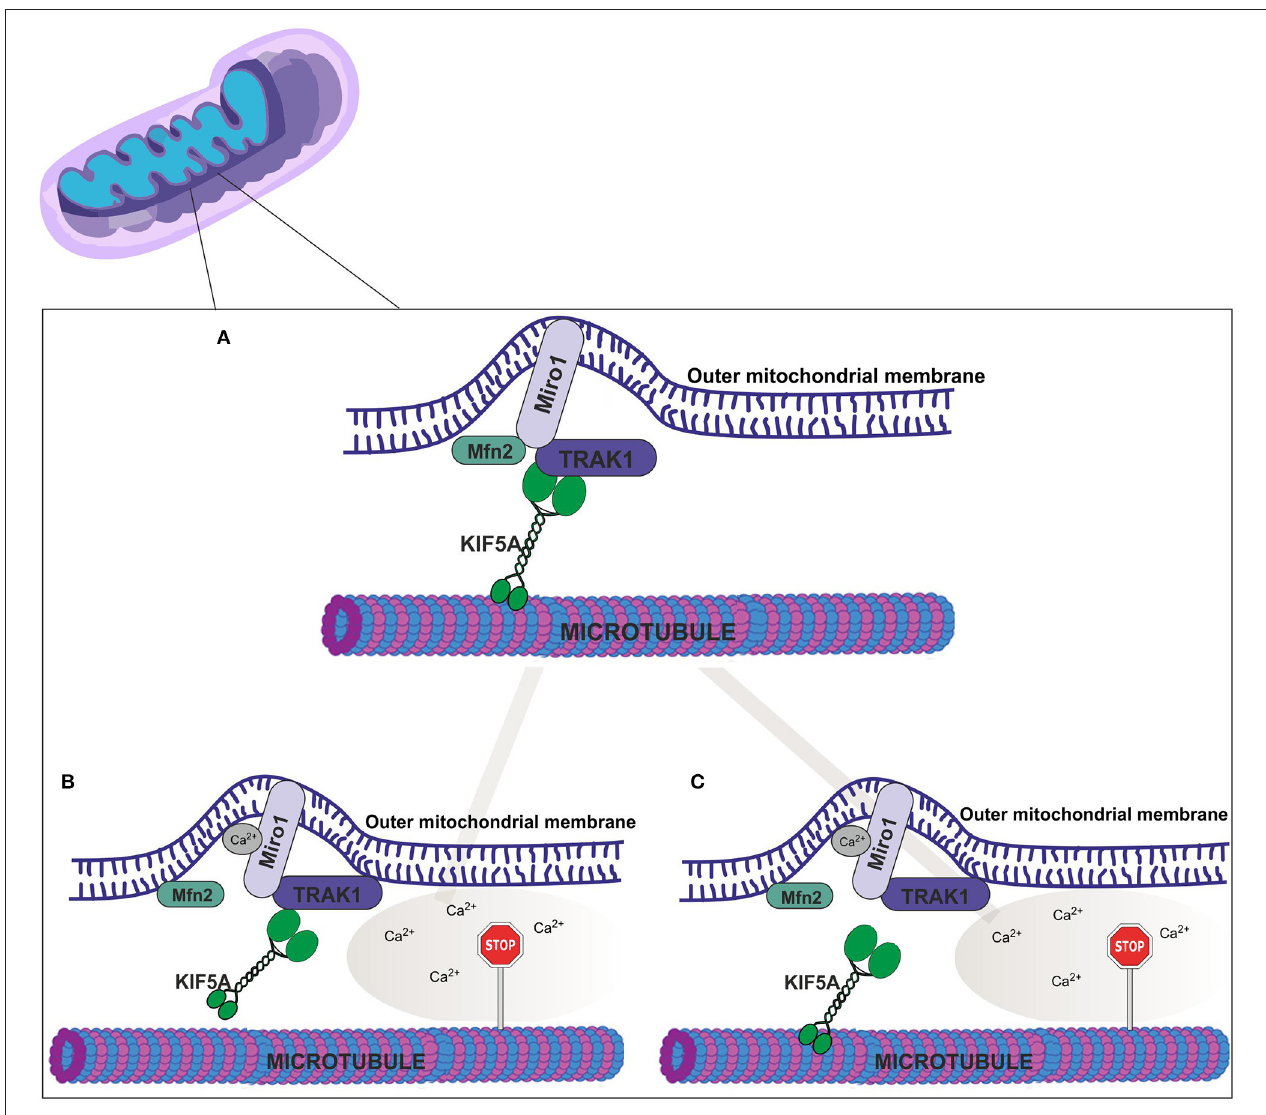
FIGURE 1 | Putative molecular mechanisms of mitochondrial movement. (A) In the absence of cytosolic Ca 2 + (nM) Miro1 (bound to the outer mitochondrial membrane) coordinates mitochondrial movement along microtubules via KIF5A, TRAK1 and Mfn2. According to literature Ca 2 + binding leads to two possible scenarios; (B) Conformational changes to Miro1, and subsequent detachment from Mfn2 and release of KIF5A from the microtubule trafficking apparatus, or (C) Detachment of Miro1 from Mfn2 and a disruption between TRAK1 and KIF5A interactions. Both scenarios result in halted mitochondrial